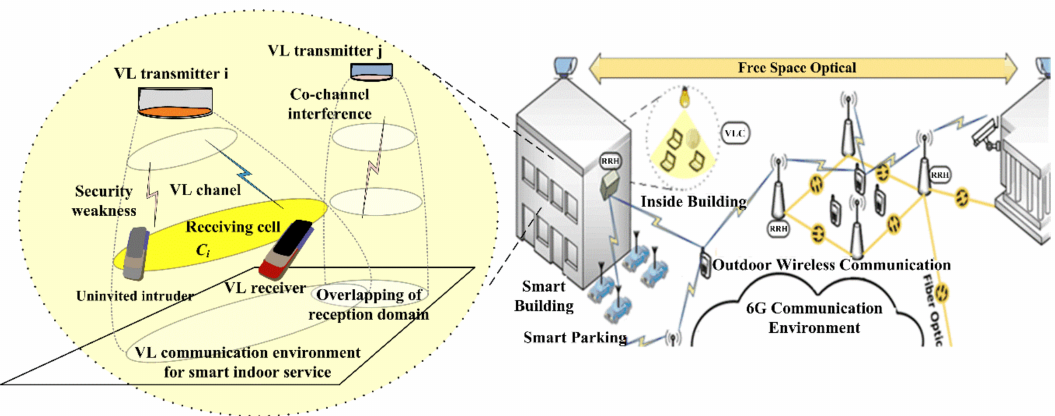
Figure 1. Example of signal interception owing to security weakness, reception error by co-channel interference, or overlapping of reception domain in environment of smart indoor service based on VL communication for 6G